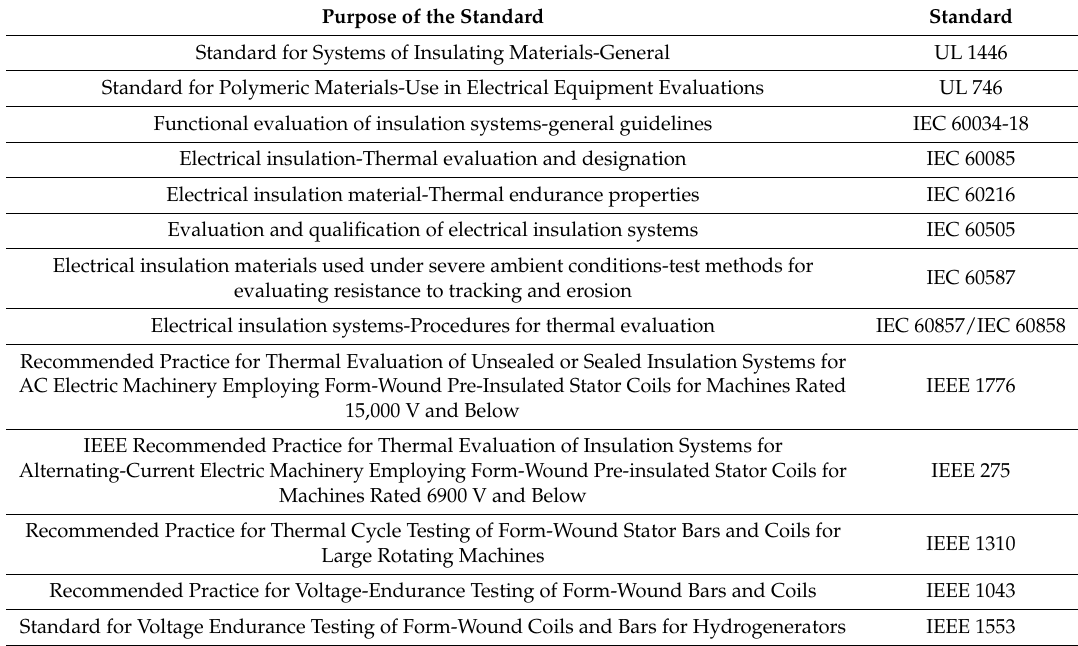
Table 5. List of standards that can be used for the qualification of an insulation